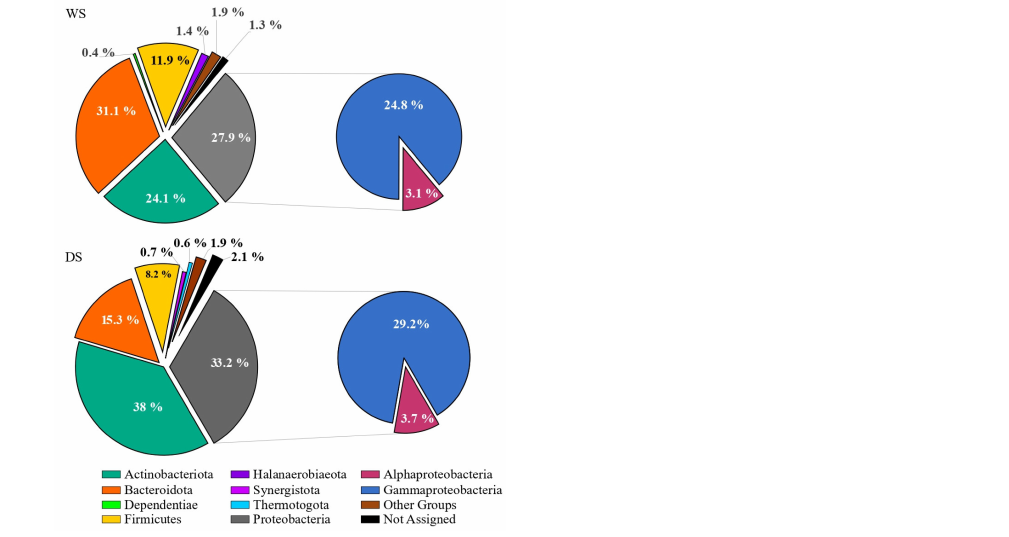
Figure 4. Comparison of phylum distribution overall observed in white and dark salt samples. WS , white salt; DS , dark salt.